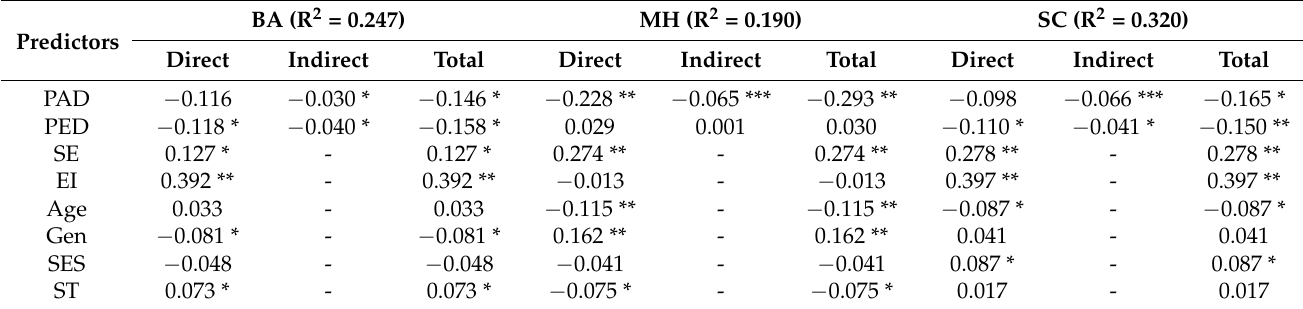
Table 4. Standardised direct, indirect, and total